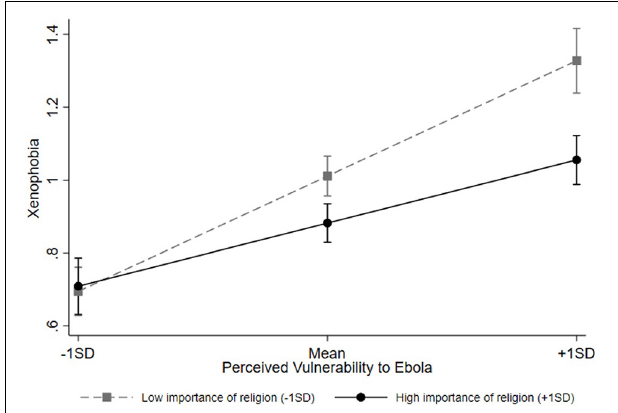
FIGURE 2 | Interaction between perceived vulnerability to Ebola and importance of religion on xenophobia. Error bars indicate 95% confidence